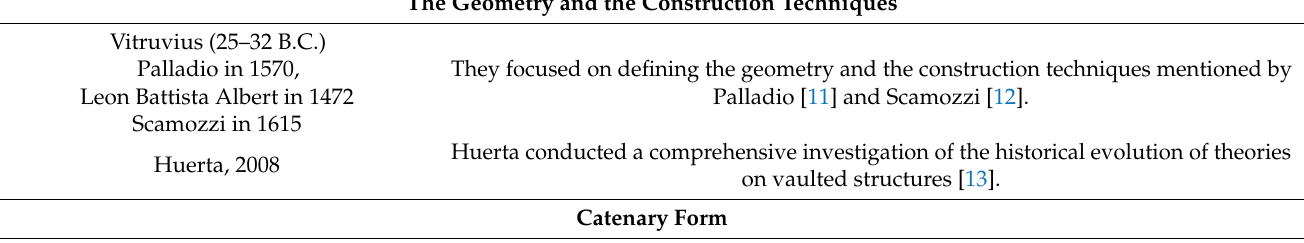
Table 1. Primitive attempts of researchers on masonry domes without considering the neutral